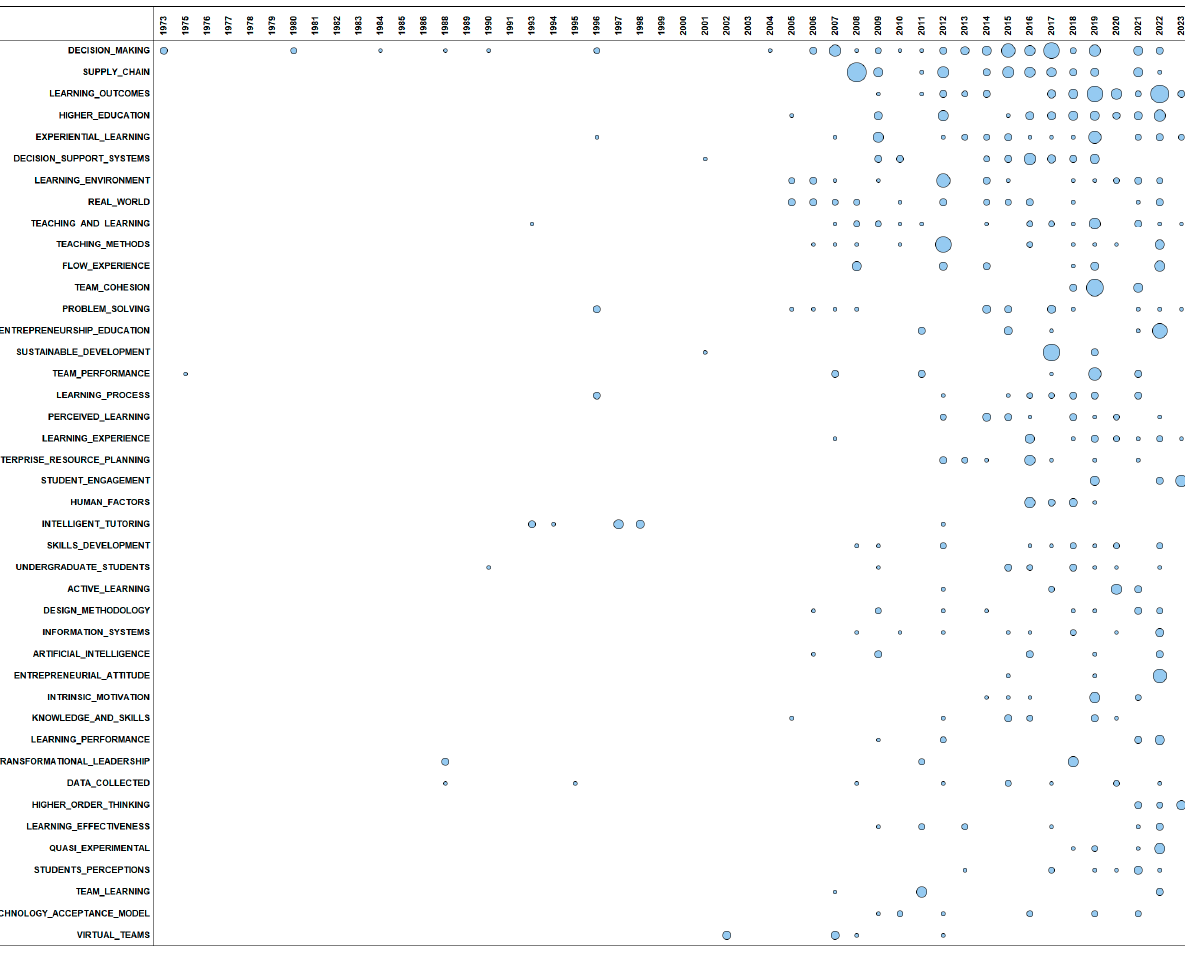
Figure 11. Bubble plot of the publication’s total frequencies; Source: Authors’ work based on Scopus.